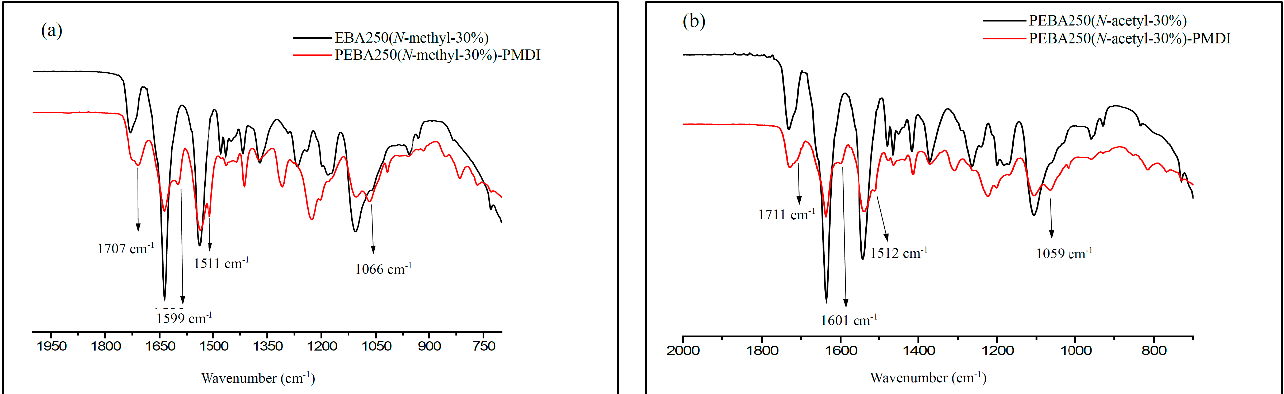
Figure 9. FT-IR spectra of ( a ) PEBA 250( N -methyl-30%), PEBA 250( N -methyl-30%)–PMDI and ( b ) PEBA 250( N -acetyl-30%), PEBA( N -acetyl-30%)–PMDI.